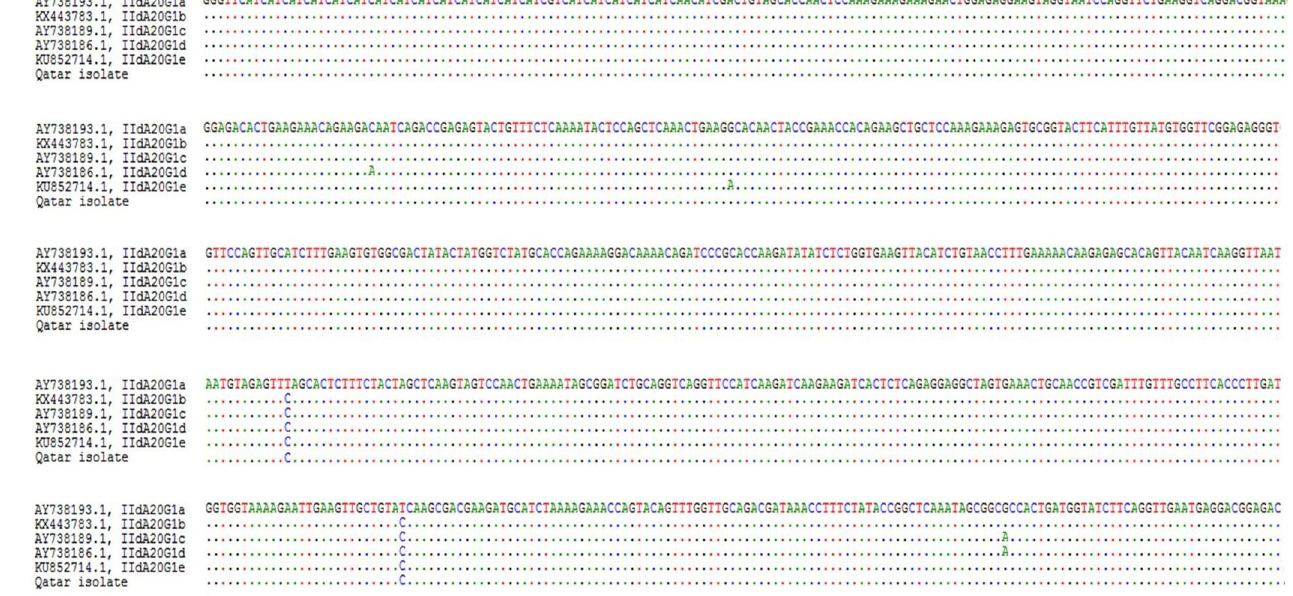
Fig 1. Multiple alignment analysis of Gp60 nPCR product sequences. Sequences are from the 5 IIdA20G1 subtypes a, b, c, d and e, and one Qatari isolate. Periods (.) indicates identical nucleotides related to the sequence of IIdA20G1a (first row).